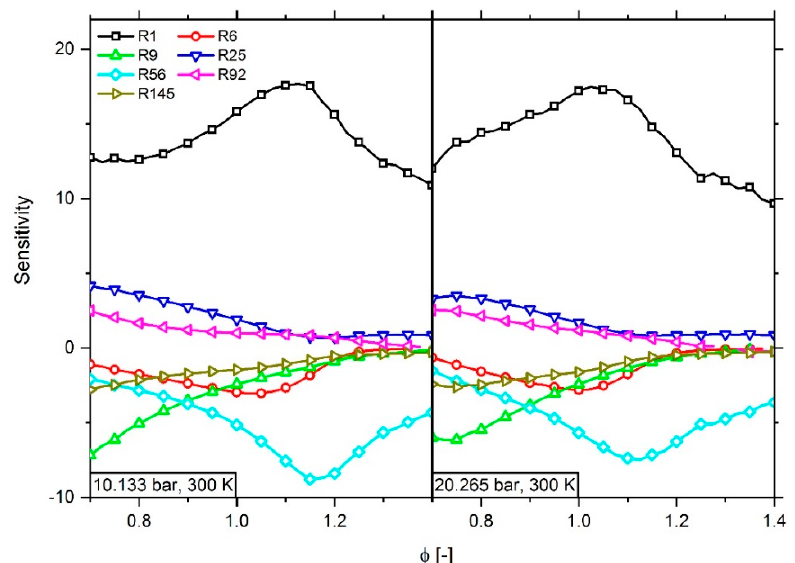
Figure 18. Analysis of the most sensitive reactions regarding the laminar flame speed as function of the fuel – air equivalence ratio φ using a methane – air mixture at 300 K and 10.133 ( left ) and 20.265 bar ( right ).